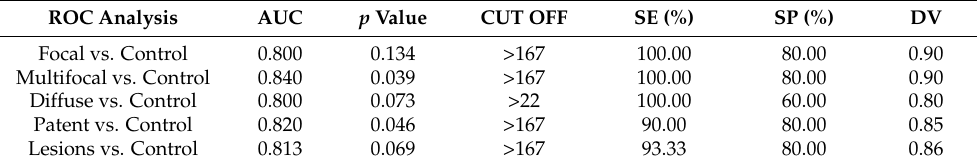
Table 3. Diagnostic performance of bovine intelectin 2 immunohistochemical quantification for diagnosis of cattle with different types of PTB-associated histological lesions in their gut tissues. ROC Analysis AUC p Value CUT OFF SE